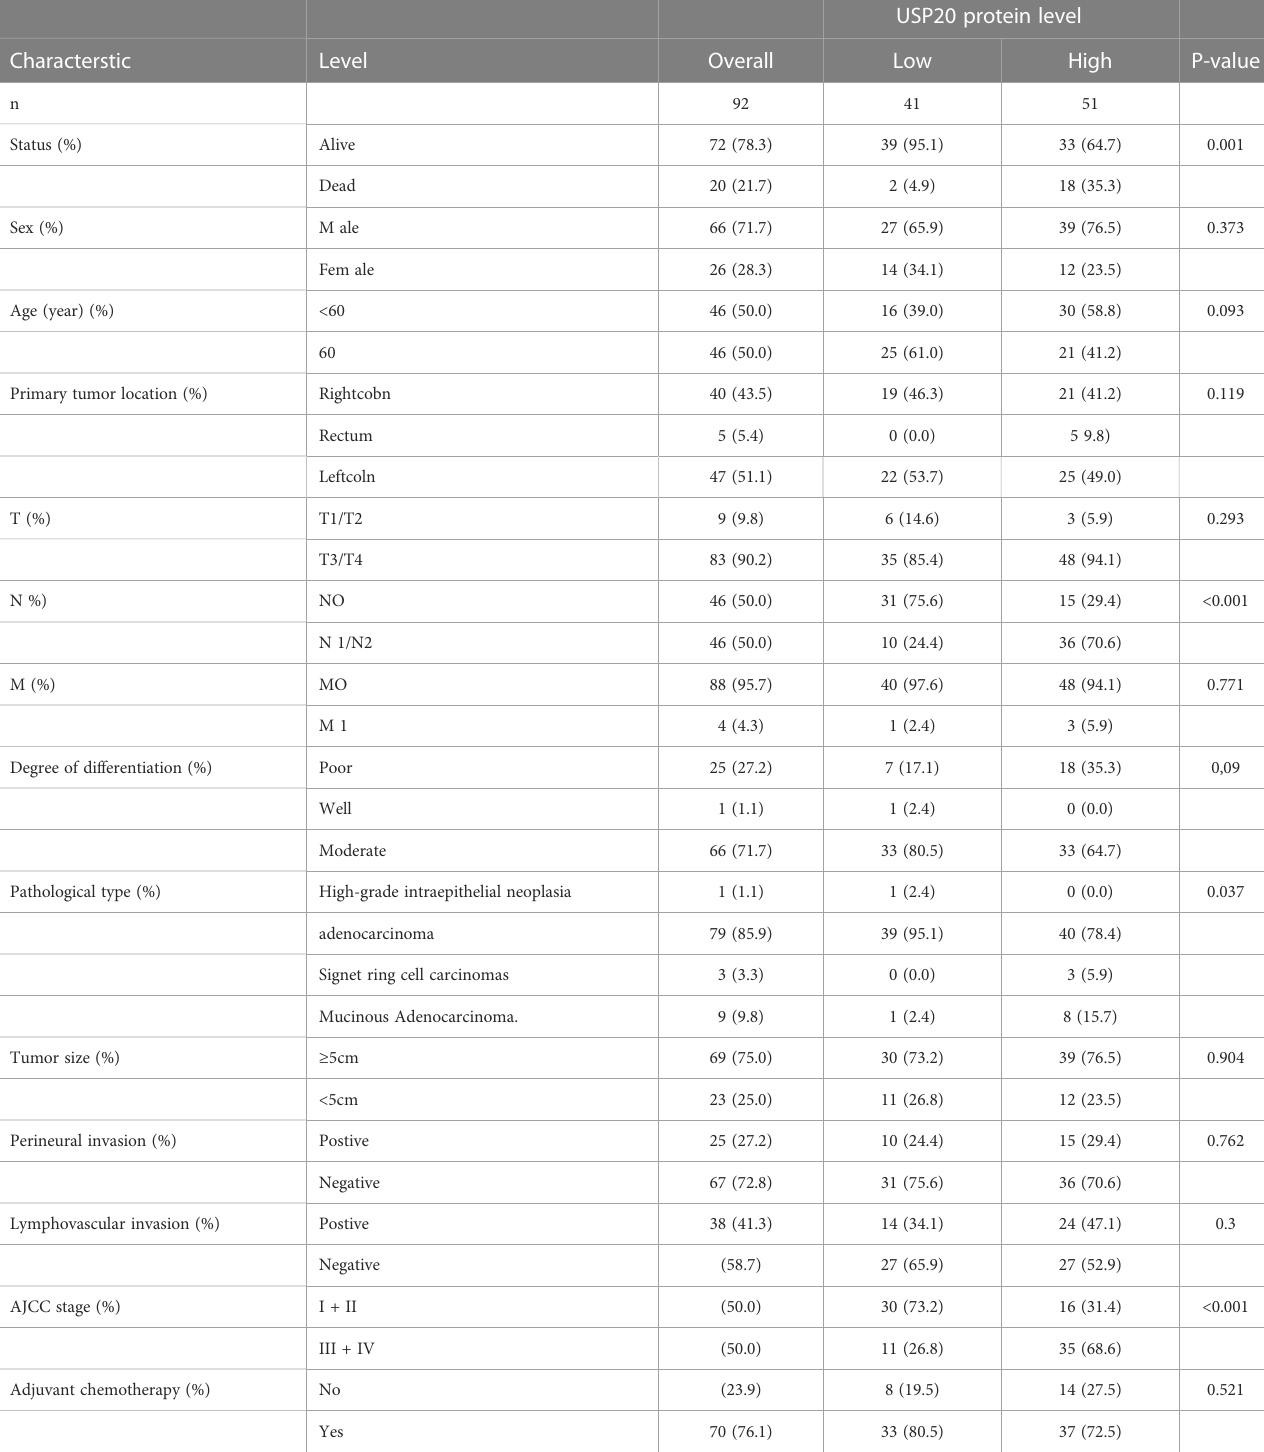
TABLE 1 Association between USP20 protein expression and clinicopathologic characteristics of patients with CRC in the fi rst study cohort